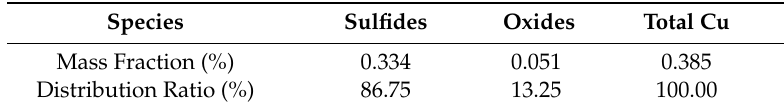
Table 2. Ore type for copper minerals.